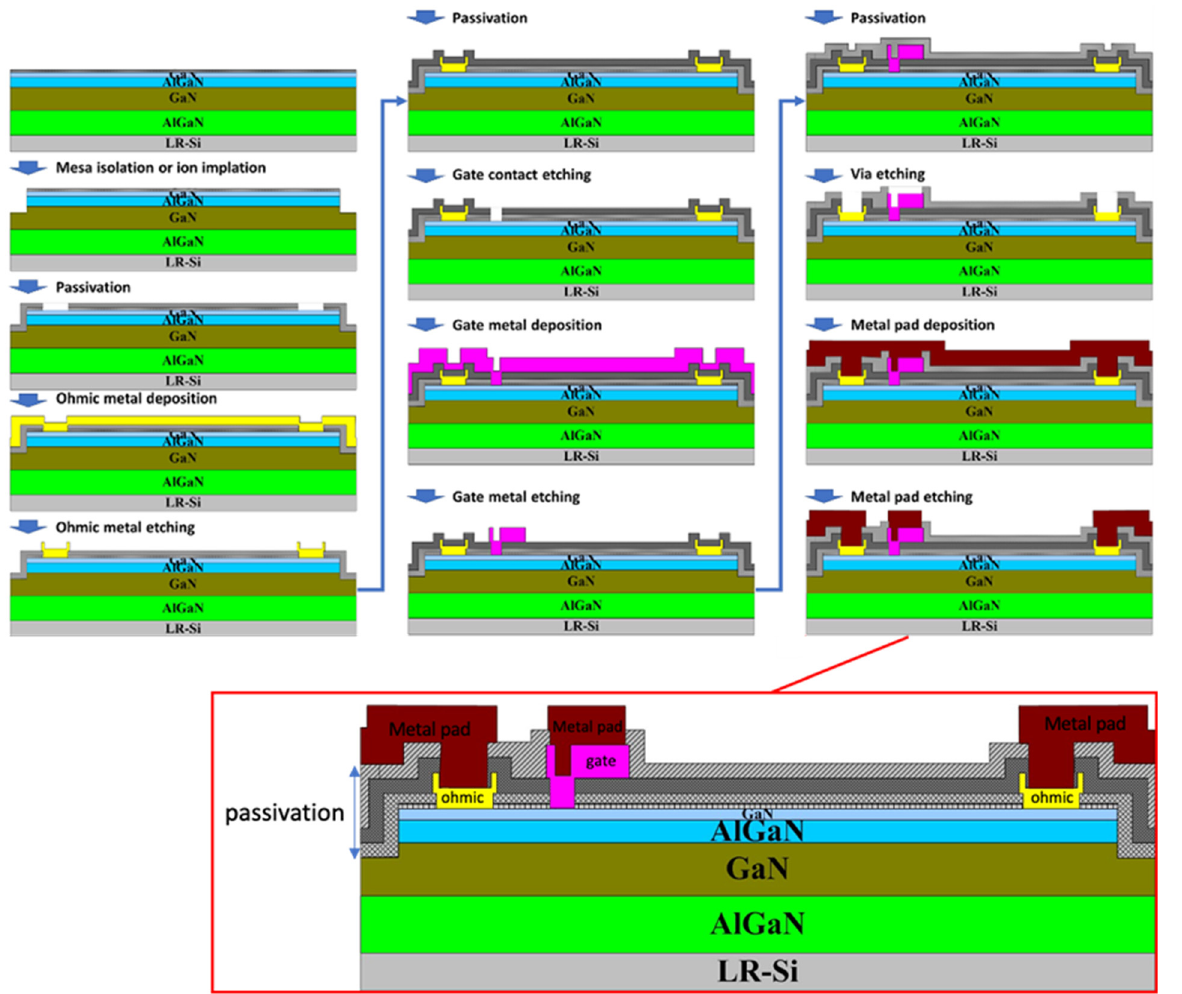
Figure 12. Au-free CMOS-compatible process.